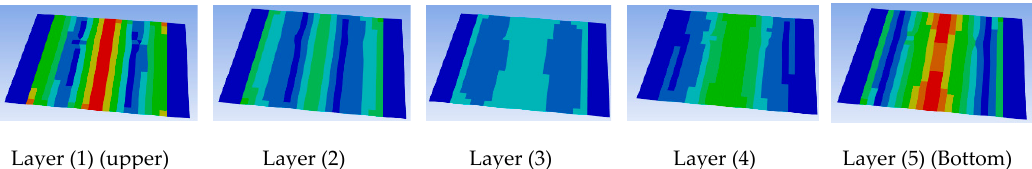
Figure 16. Layers failure criteria.